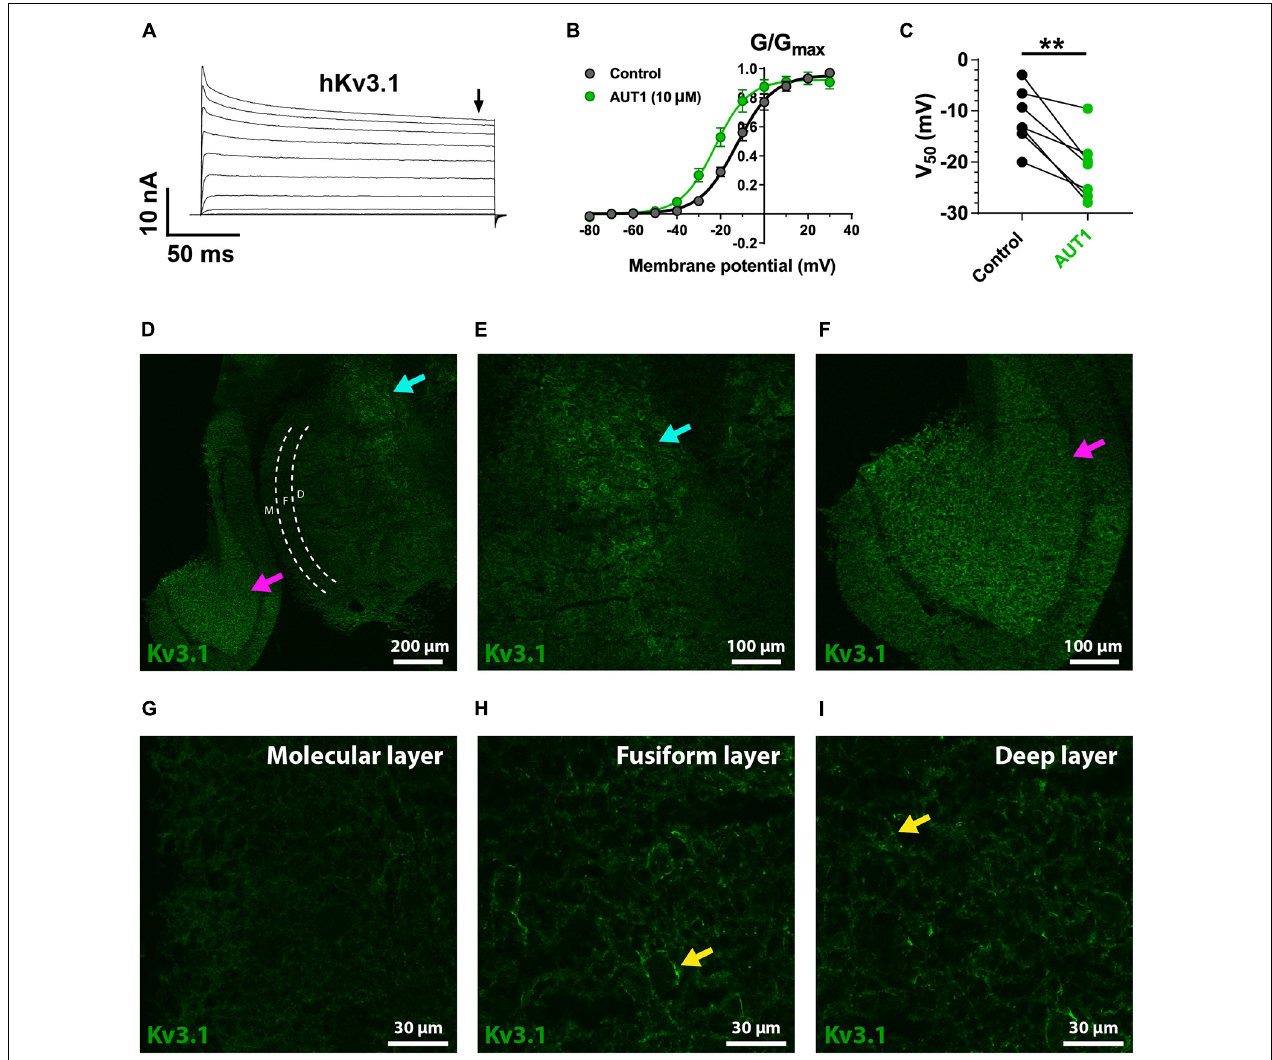
FIGURE 5 | Kv3.1 K + channel functional characteristics and expression in the dorsal cochlear nucleus. (A) Whole-cell voltage clamp recordings showing outward currents recorded form HEK 293 cells stably expressing Kv3.1b K + channels (hKv3.1) in response to command voltages stepped from –80 to 40 mV in 10 mV increments. (B) Normalized conductance (G/G max ) curves plotted as a function of the step potentials (mean ± SEM), in the control condition (black) and following perfusion of 10 µ M AUT1 (green). Currents were measured at the end of the voltage step (arrow in panel A ). Data were fitted using a Boltzmann function. (C) Half-activation voltages (V 50 ) obtained from the Boltzmann curves in the control (black) and AUT1 (green) conditions. Perfusion of AUT1 caused a significant shift in V 50 to more negative voltages ( n = 7). (D) Confocal image from a sagittal brainstem slice (12 µ m) showing weak labeling of Kv3.1b K + channels in the DCN. The DCN is partitioned into its three layers (molecular layer: white “M”; fusiform layer: white “F”; deep layer: white “D”) using white dashed lines. The cyan and magenta arrows indicate labeling of Kv3.1b K + channels in the brainstem at a location medial with respect to the DCN (cyan arrow) and in the cerebellar granule cell layer (magenta arrow). (E,F) Panel (D) with increased zoom showing locations marked by the cyan ( E , top right in panel D ) and magenta ( F , bottom left in panel D ) arrows. (G–I) Images of increased magnification showing the molecular (G) , fusiform (H) , and deep (I) layers. The yellow arrows (H,I) reveal a weak expression of Kv3.1b K + channels on cell bodies. ** p < 0.01.